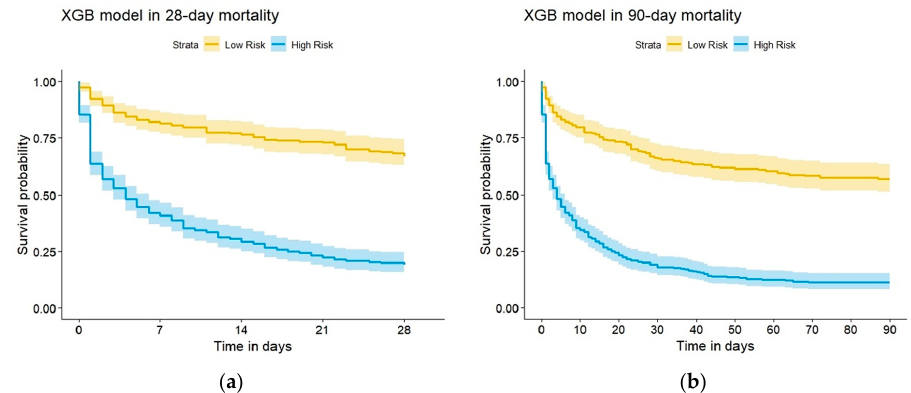
Figure 6. The Kaplan–Meier curve for predicting the 28-day and 90-day mortality. ( a ) 28-day mortality, ( b ) 90-day mortality.